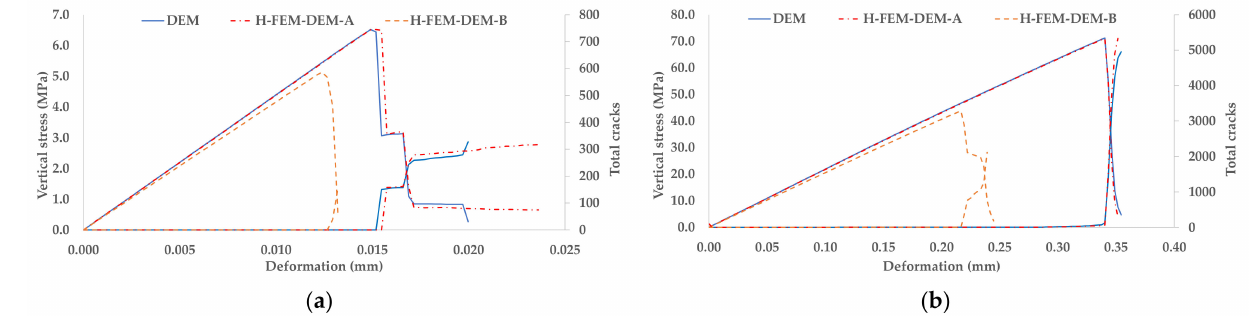
Figure 9. Stress/Deformation diagram and crack evolution for uniaxial tests—refined particle assembly: ( a ) tensile test; ( b ) compression test.